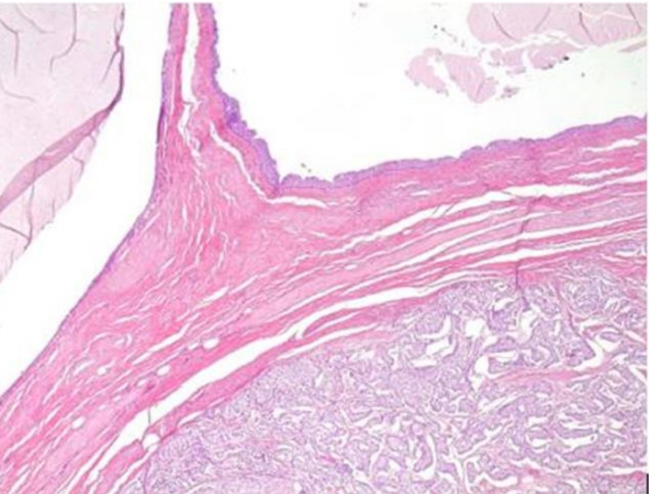
Figure 3. Histological examination: An area of the multiloculated cyst with an immature, mucus- secreting intestinal epithelial lining below the two lumens. The neuroendocrine neoplasm consists of nests and bundles of small monomorphic cells with a characteristic organoid growth pattern (hematoxylin and eosin 5 ×